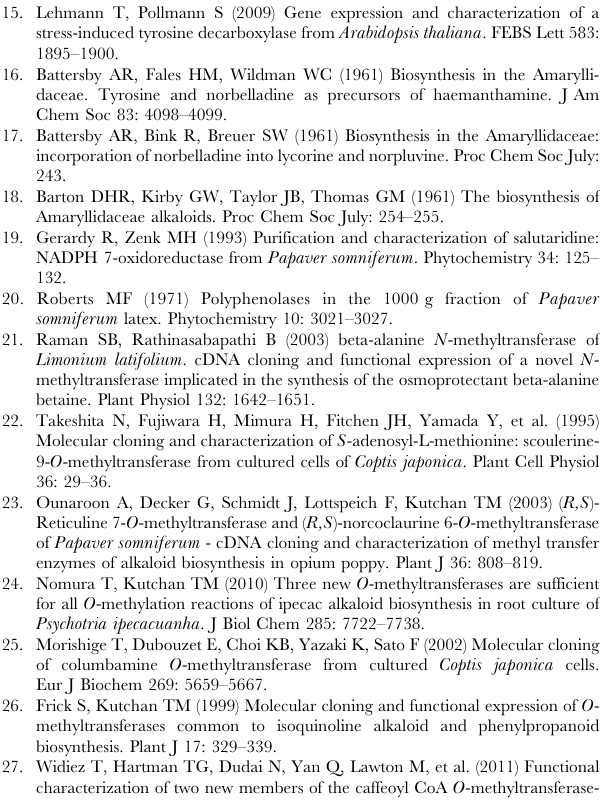
Figure S1 Np N4OMT1 product 4 9 - O -methylnorbella- dine proton NMR spectra with peak assignments. (TIF) Figure S2 Np N4OMT1 product 4 9 - O -methylnorbella- dine COSY spectra. (TIF) Figure S3 Np N4OMT1 product 4 9 - O -methylnorbella- dine HMBC spectra. (TIF) Figure S4 Np N4OMT1 product 4 9 - O -methylnorbella- dine ROESY spectra. (TIF) Figure S5 Np N4OMT1 product 4 9 - O -methylnorbella- dine HSQC spectra. (TIF) Figure S6 Protein sequence alignment of Np N4OMT variants. Five unique variants of the Np N4OMT sequence are aligned against the original sequence predicted by the de novo assembled transcriptome using CLC software. Dots are identical residues. (TIF) Figure S7 Effect of divalent cations, temperature and pH on Np N4OMT1 enzyme activity. (A) Divalent cations tested with 5 min assays with 5 m M of cation Ca 2 + , Co 2 + , Zn 2 + , Mg 2 + or Mn 2 + . (B) pH optimum 15 min assays with 5 m M Mg 2 + . (C) Temperature optimum 15 min assays with 5 m M Mg 2 + .